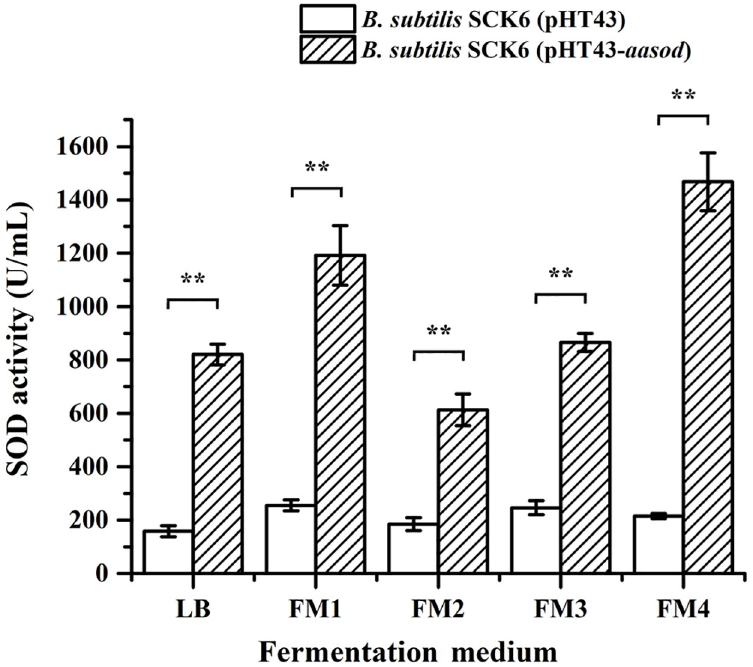
Fig 2. Comparison of fermentation media for Aa SOD production. The data are expressed as the mean ± SD of three independent experiments. �� Represents significant difference ( p < 0.01) between groups.